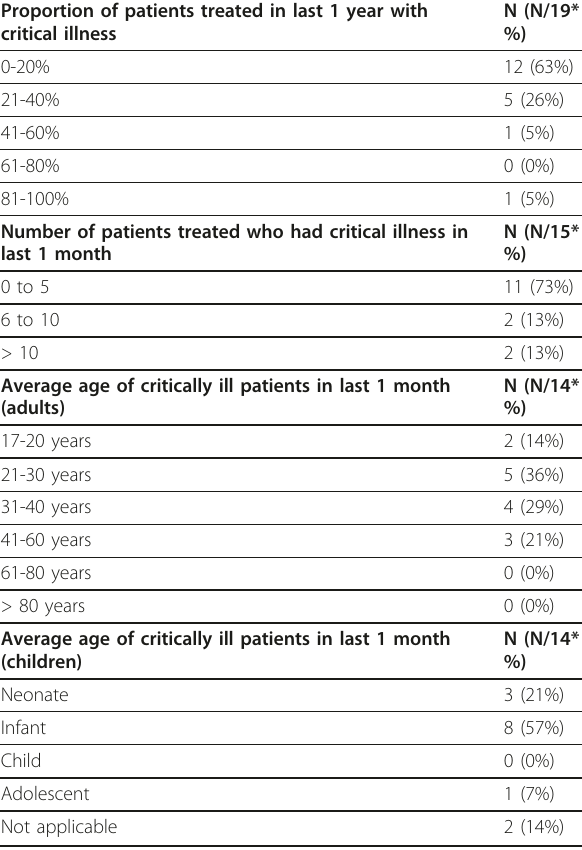
Table 1 Proportion and age of patients with critical illness in the Solomon